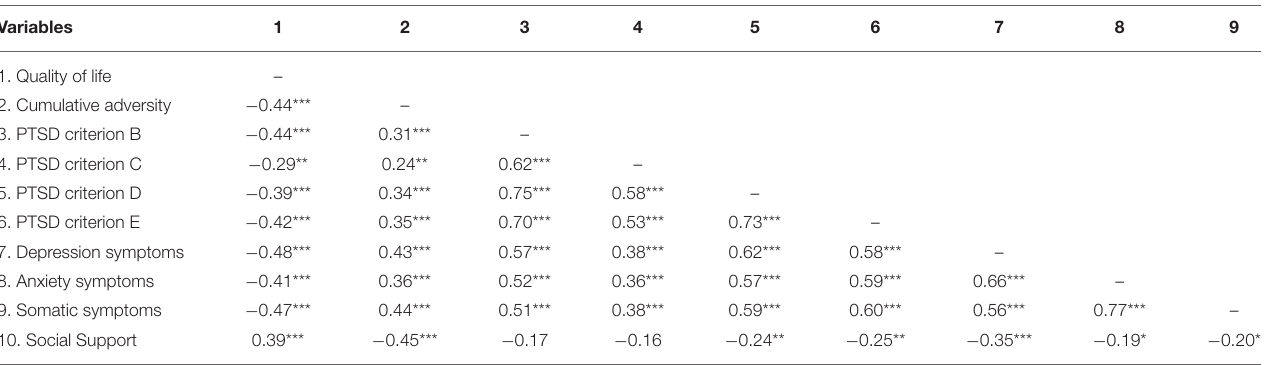
TABLE 2 | Correlations of key measures.